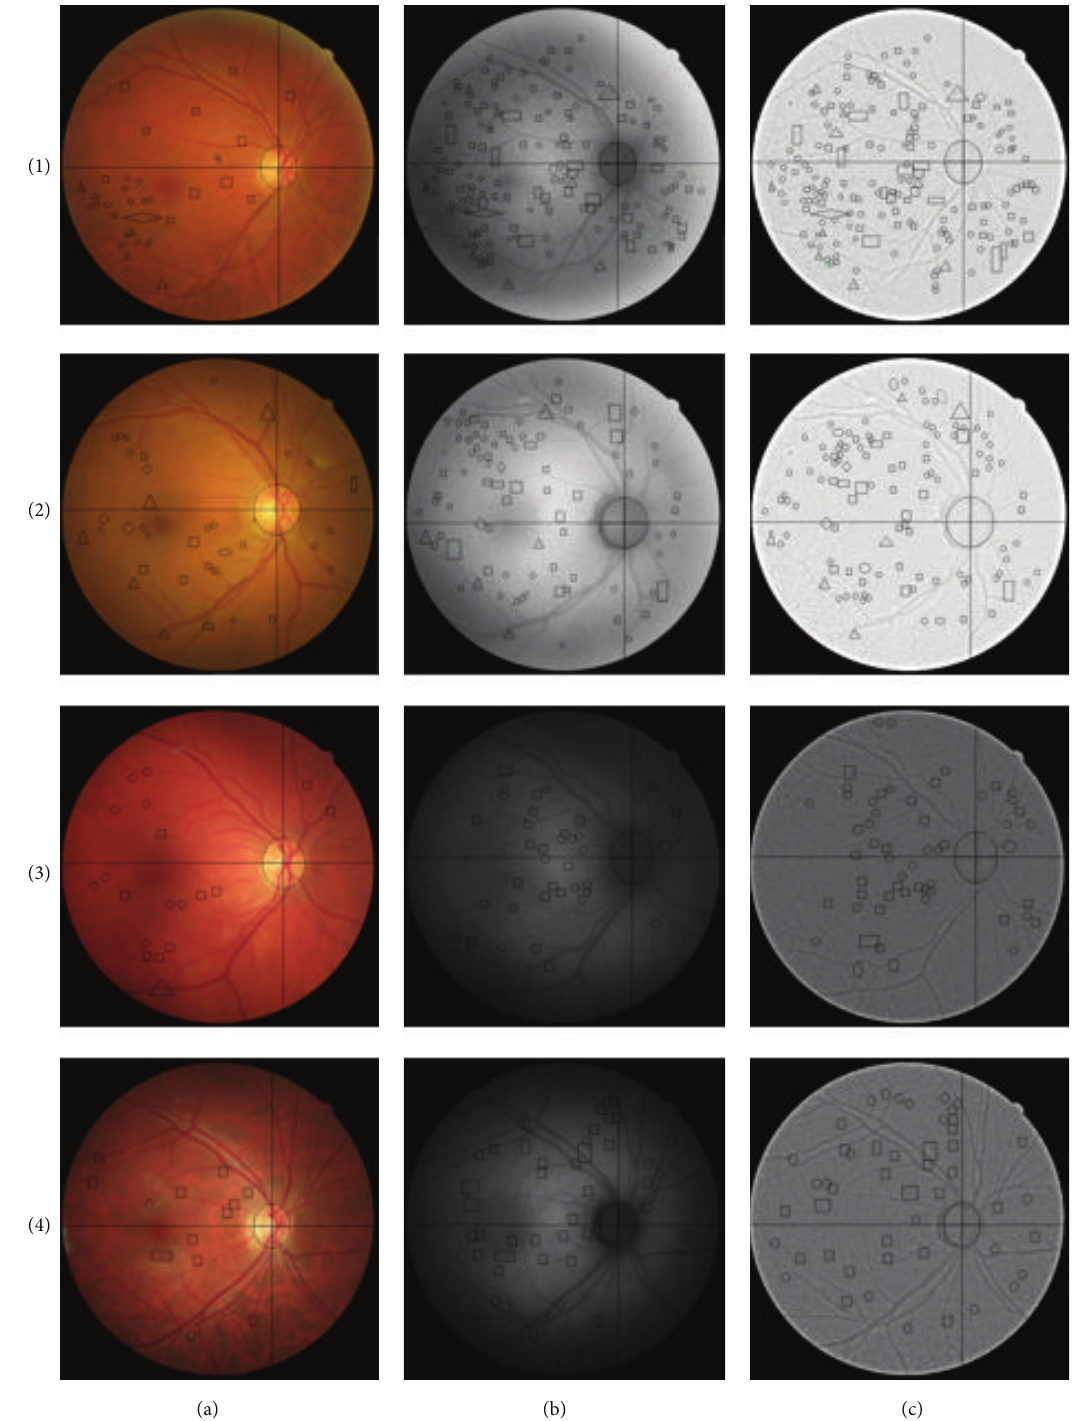
Figure 4: Colour fundus imaging (a), FAF imaging (b), and optimized-FAF (c) of (1) insulin dependent diabetes mellitus patient, diabetes duration 18 years; (2) noninsulin dependent diabetes mellitus patient, diabetes duration 30 years; (3) control subject with risk of developing diabetes mellitus; (4) control subject without risk of developing diabetes mellitus. Signs compatible with microaneurysms were represented by circle form, capillary dilation, haemorrhages, and hard exudates by square, triangle, and rhombus forms,